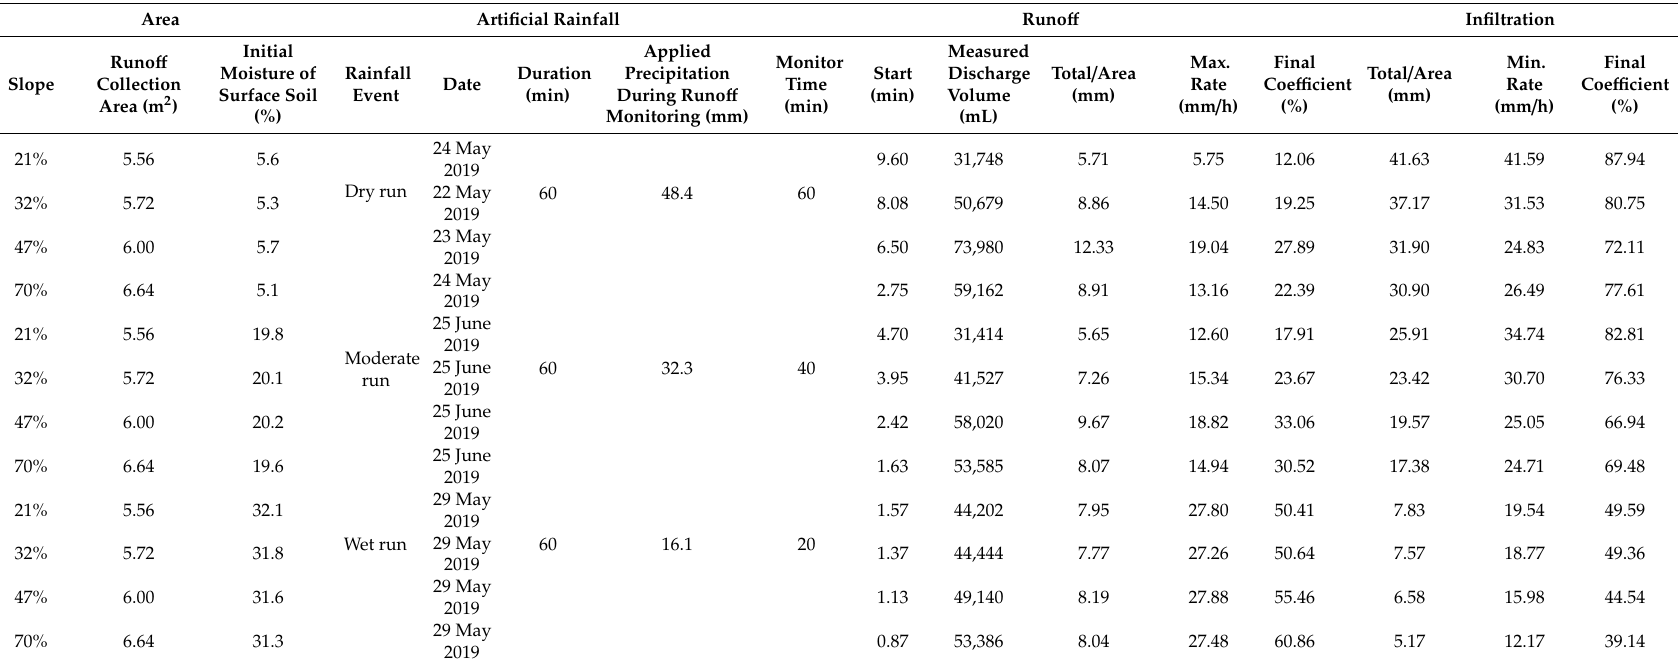
Table 2. Summary of runo ff and infiltration of the slopes under simulated